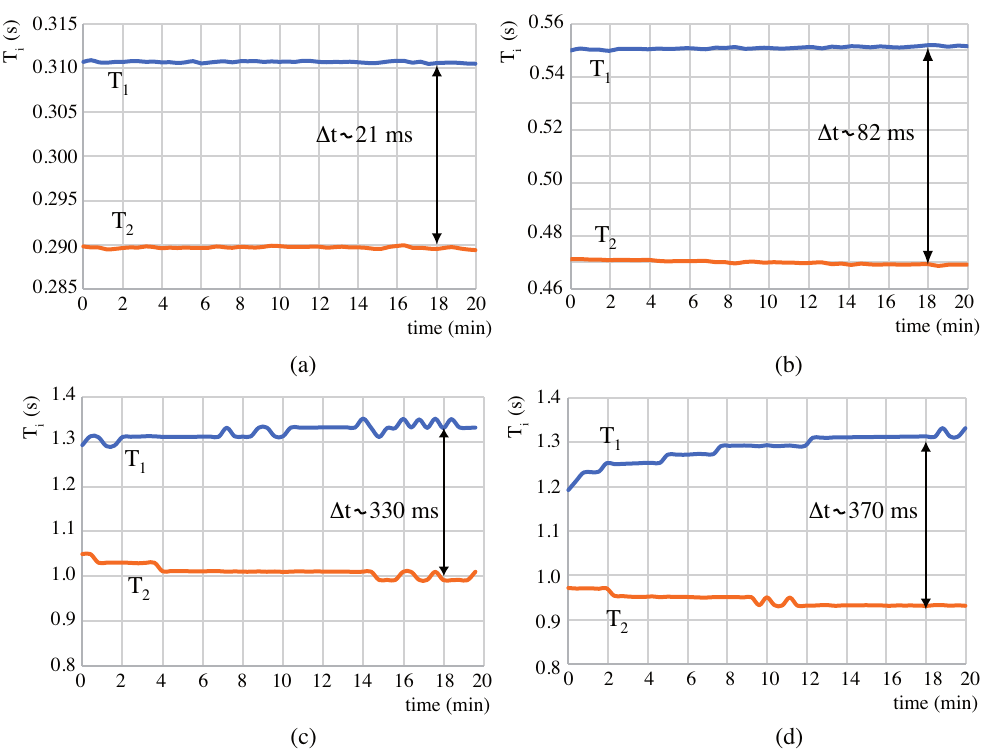
Figure 6. Experimental results for charge/discharge times T 1 , T 2 and its associated ∆ t for: ( a ) Douglas-fir, ( b ) Sweet chestnut, ( c ) Maritime pine, ( d ) European